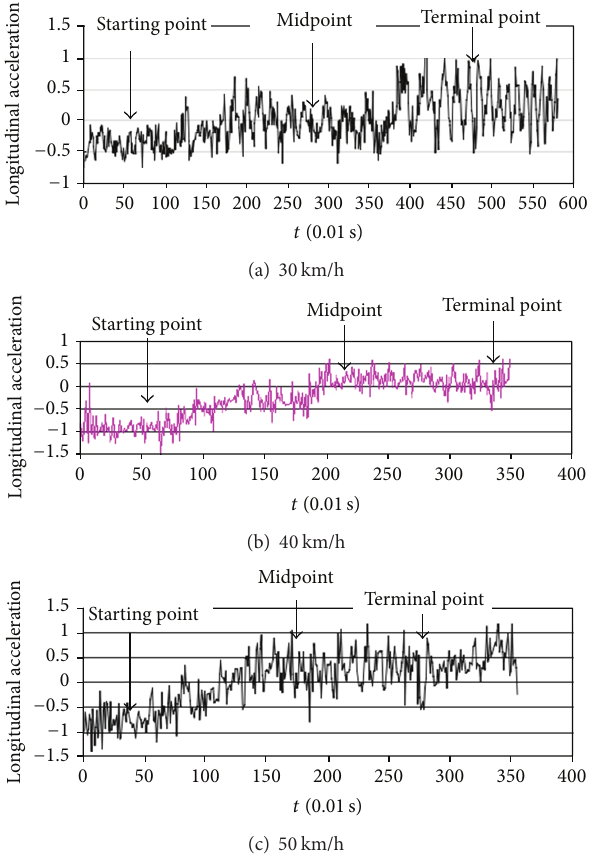
Figure 4: Longitudinal acceleration distribution of motor coach with different speed passing